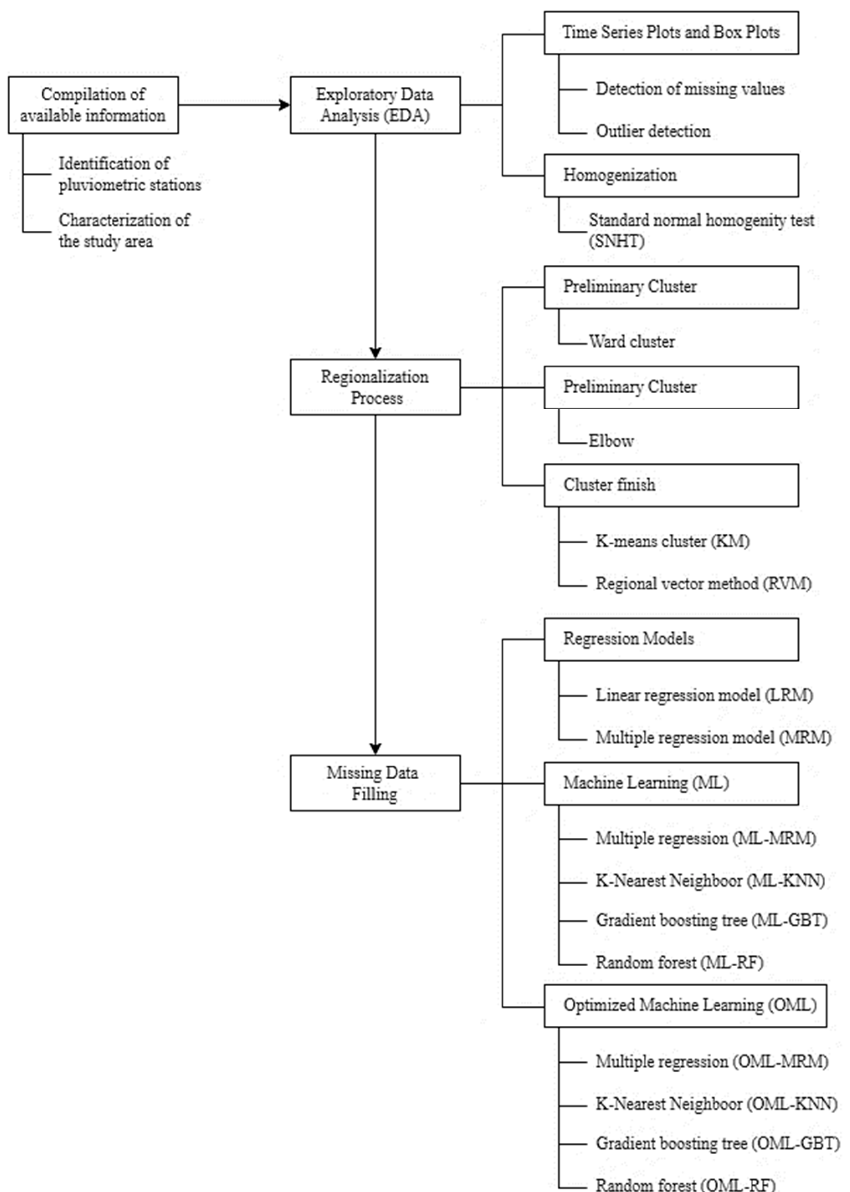
Figure 2. Methodological diagram for daily precipitation series gap filling.